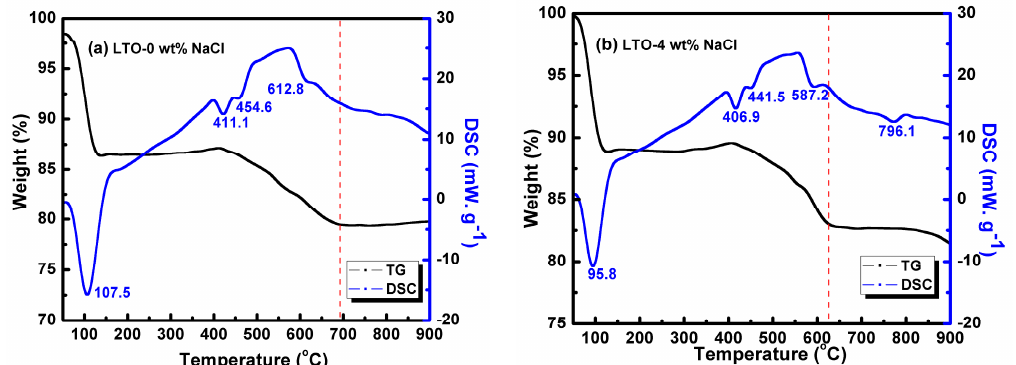
Figure 7. Thermogravimetric and di ff erential scanning calorimeter (TG-DSC) curve of LTO formation.